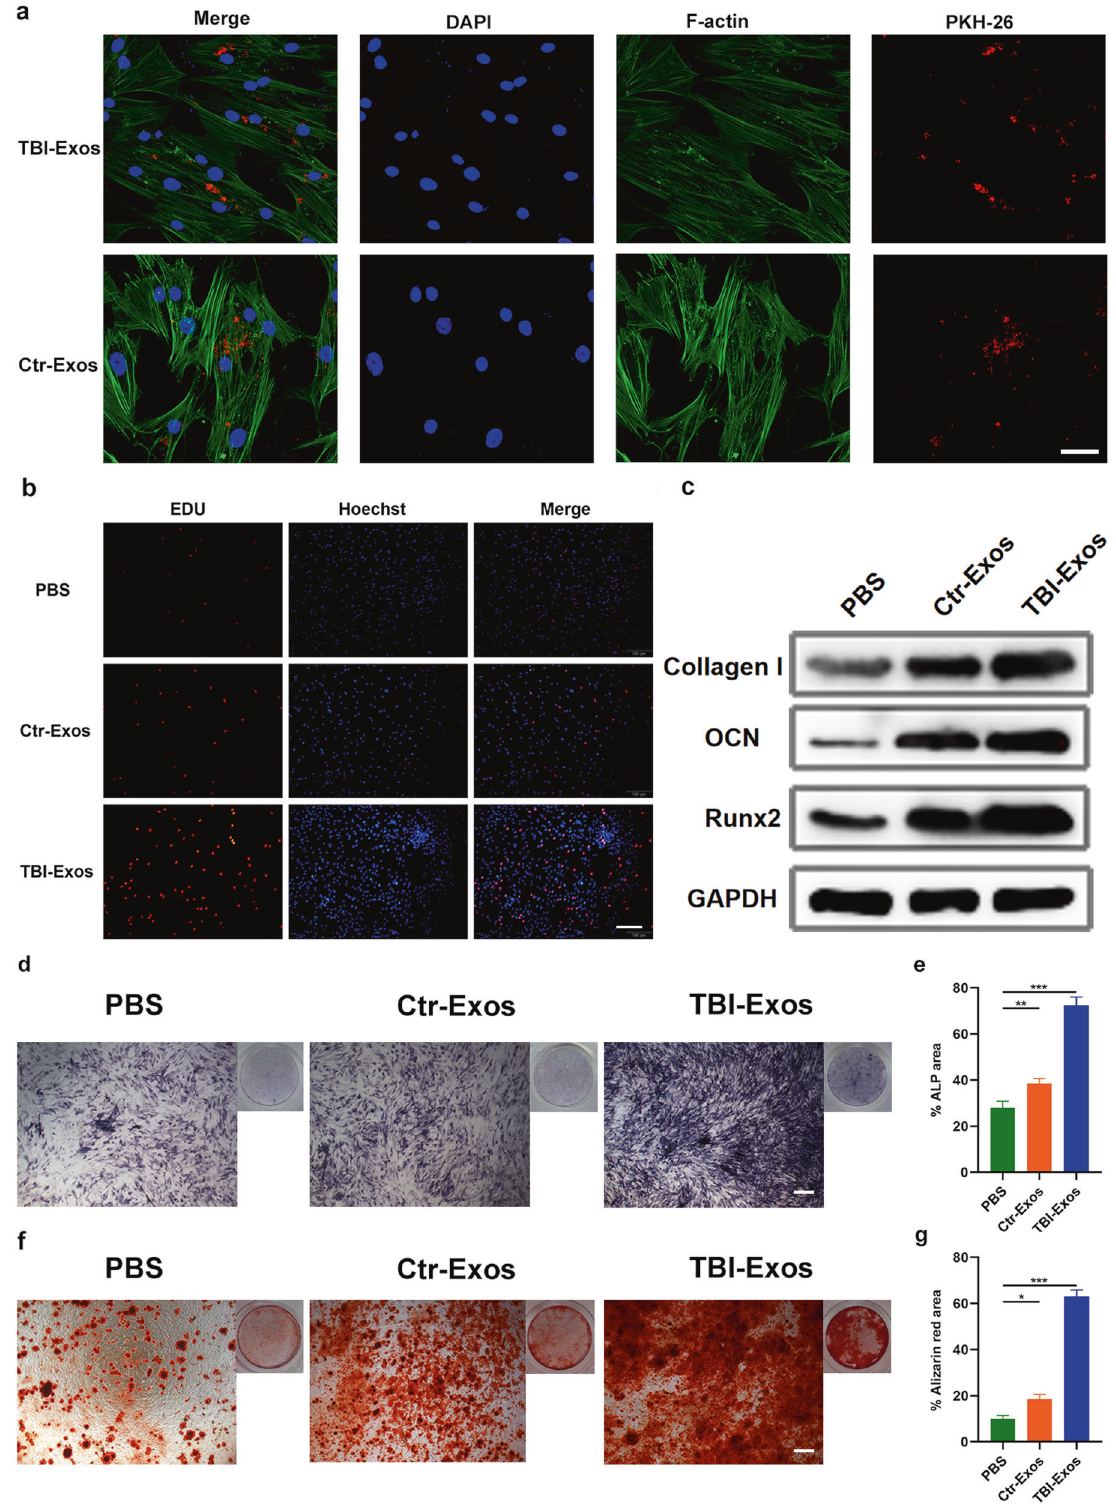
Fig. 3 TBI-Exos promote hMSC proliferation and osteogenic differentiation. a Uptake assay of Ctr-Exos and TBI-Exos in hMSCs. Scale bar: 50 μ m. b EdU assay results of hMSCs with different treatments. Scale bar: 50 μ m. c The levels of osteogenic-related proteins were measured by western blotting. d , e ALP staining results of hMSCs in the different groups. f , g Alizarin red staining results of hMSCs in the different groups. Data are the mean ± SD of triplicate experiments. * p < 0.05, ** p < 0.01, *** p <